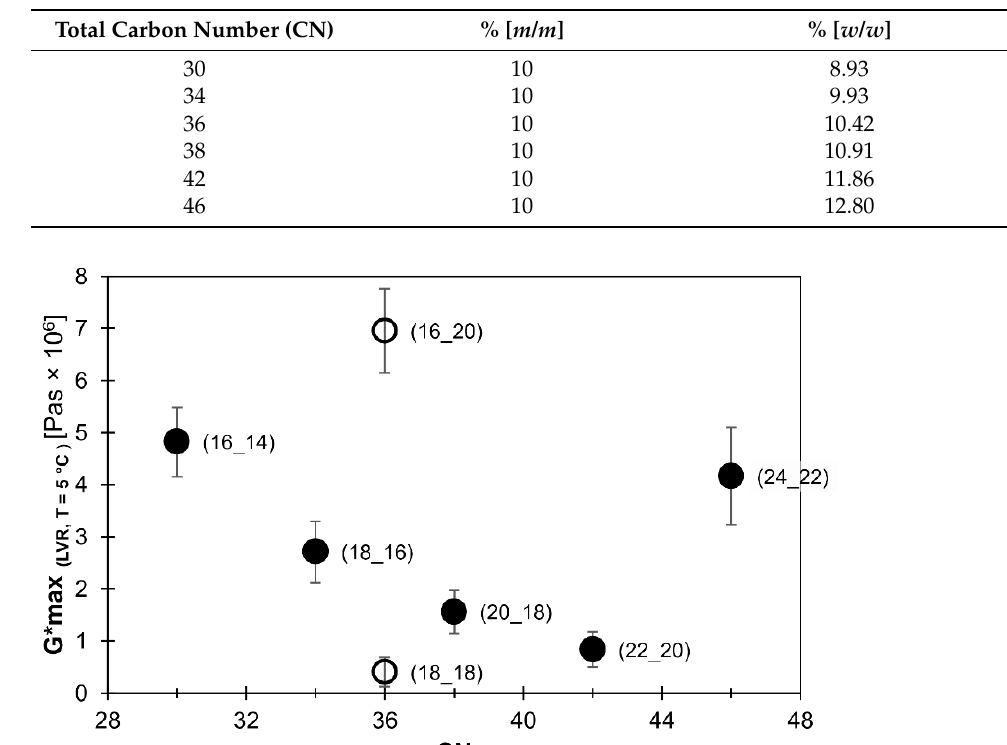
Table 1. Total weight fraction for wax esters of different total carbon numbers (CN) for an inclusion level of 10% on a molar basis (% [ m/m ]) and, respectively, on a weight basis (% [ w / w ]). Total Carbon Number (CN)